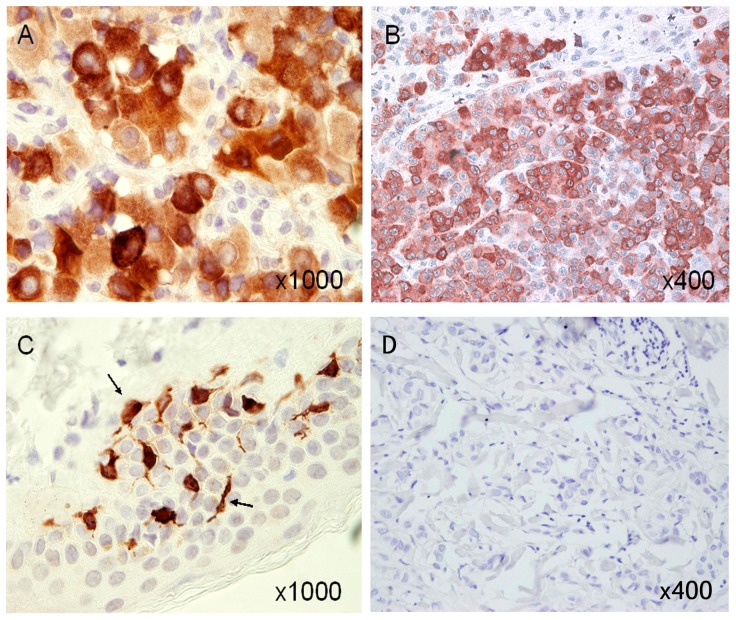
Immunohistochemical staining of melanoma tumor tissues with the 2A9
mAb.2A9 mAb staining of a primary tumor and of one metastasis from the same
melanoma patient is shown in (A) and (B), respectively; staining of melanocytes
present in epidermis is shown in (C), while no staining of keratinocytes is
observed. Black arrows indicate melanocytes. No staining is observed with
a breast carcinoma tumor biopsy (D). Original magnification: A and C = 1000×;
B and D = 400×.